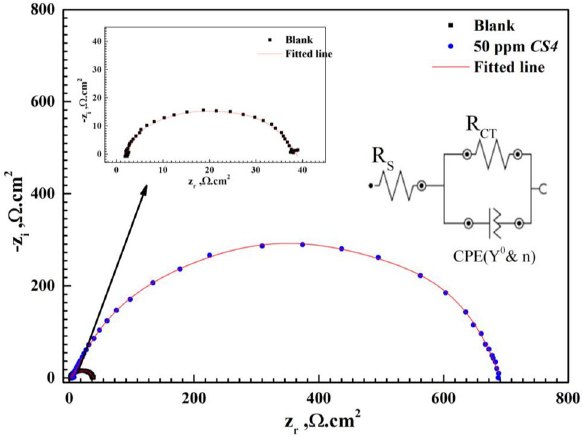
Figure 6. Nyquist plots of CS -steel in 1 M HCl with and without high concentration (50 ppm) of CS4 using the proposed equivalent circuit.